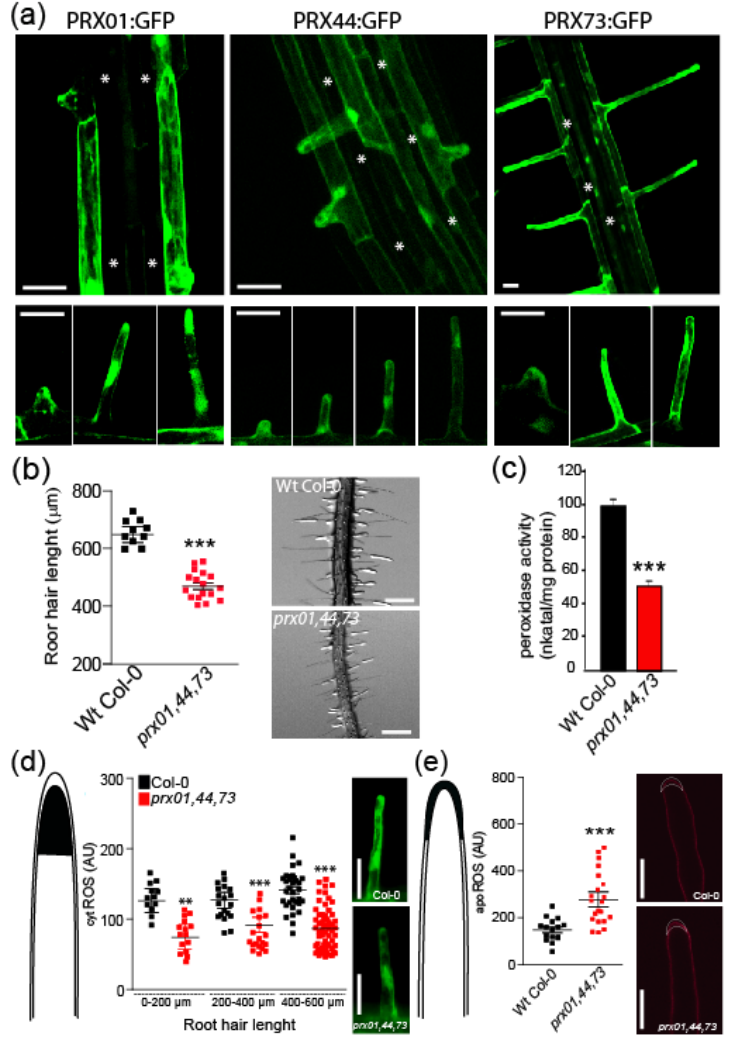
Figure 1. Characterization of root-hair-specific PRX01, PRX44, and PRX73 expression and mutant analysis. ( a ) GFP-tagged transcriptional reporters of PRX01, PRX44, and PRX73 show expression in the root elongation zone and specifically in root hairs (bottom). Scale bar = 200 μ m. (*) indicates atrichoblast cell files, which lack GFP expression. ( b ) Root hair length phenotype of Wt Col-0 and the prx01,44,73 triple mutant. Left, box-plot of root hair length. Horizontal lines show the means. P-value determined by one-way ANOVA, (***) p < 0.001. Right, bright-field images exemplifying the root hair phenotype in each genotype. Scale bars = 500 μ m. ( c ) Peroxidase activity in Wt Col-0 and prx01,44,73 triple mutant roots. Enzyme activity values (expressed as nkatal/mg protein) are shown as the mean of three replicates ± SD. P-value determined by one-way ANOVA, (***) p < 0.001. ( d ) Cytoplasmic ROS levels measured with H2DCF-DA in Wt and prx01,44,73 triple mutant root hairs. Right, horizontal lines show the means. p -values determined by two-way ANOVA, (***) p < 0.001 and (**) p < 0.01. Right, fluorescence images exemplifying cyt ROS detection in root hairs. Scale bars, 20 μ m. ( e ) Apoplastic ROS levels measured with Amplex™ UltraRed (AUR) in Wt and prx01,44,73 triple mutant root hairs. ROS signal was quantified from the root hair cell tip. Left, box-plot of apo ROS values. Horizontal lines show the means. p -value determined by one-way ANOVA, (***) p < 0.001. Right, fluorescence images exemplifying apoROS detection in root hair apoplast. Scale bars, 200 μ m.